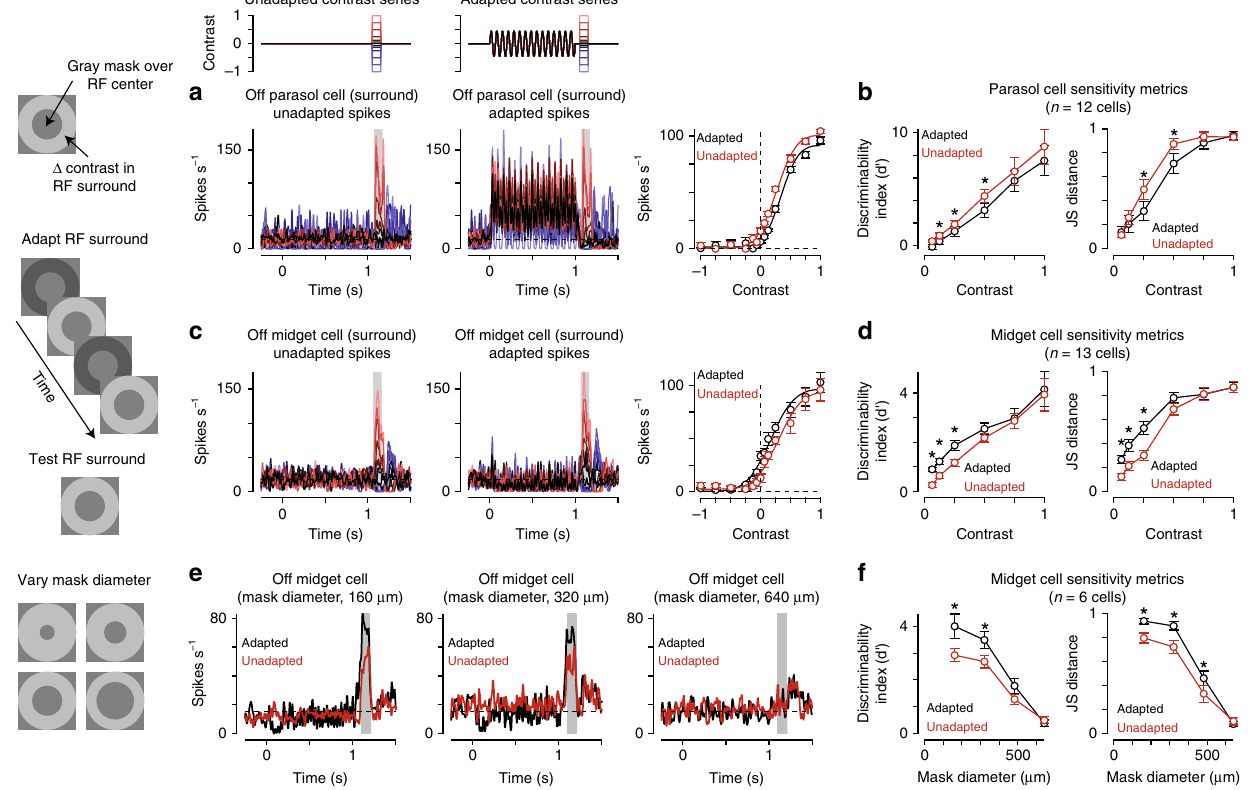
Fig. 4 Sensitization arises in the receptive- fi eld surround. a Spike responses from an Off parasol ganglion cell to a series of stimuli presented in the receptive- fi eld surround. Annuli were presented in isolation (left) or following an adapting stimulus that was also presented in the receptive- fi eld surround (middle). The adapting stimulus evoked a decrease in spiking at positive contrasts relative to the unadapted condition (red). b Discriminability index ( d ′ ; left) and Jensen-Shannon distance (right) for contrast responses relative to background noise in parasol ganglion cells ( n = 12). Statistically signi fi cant change in sensitivity indicated with asterisk. c Responses from an Off midget ganglion cell to the surround adaptation stimulus paradigm. Consistent with weak contrast sensitization, the adapting stimulus elicited a slight leftward shift in the contrast-response function relative to the control condition (right). d Sensitivity indices in 12 midget ganglion cells for surround test fl ashes. e Sensitization varies with the degree of surround stimulation. Spike responses from an Off midget cell to the surround adaptation stimulus for three mask diameters. For some mask diameters, surround adaptation (black) produced larger spike responses during the surround fl ash relative to the unadapted condition (red). This increase in responsiveness was not present for the largest mask diameter (640 μ m, right). f Sensitivity metrics for four mask diameters in midget ganglion cells ( n = 6 cells). Surround adaptation produced signi fi cant larger d ′ values for mask diameters ≤ 320 μ m and Jensen-Shannon distance values for diameters ≤ 480 μ m ( p < 0.05; Wilcoxon signed rank test). Error bars indicate mean ±